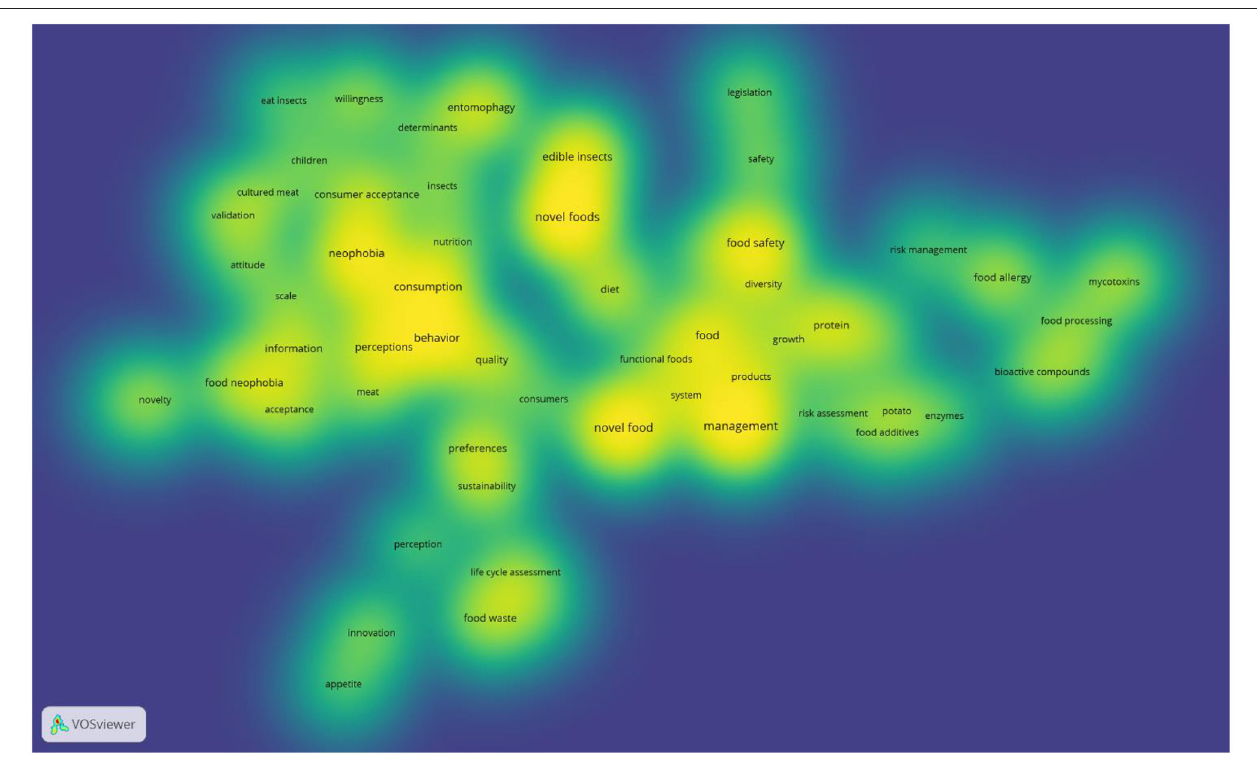
FIGURE 9 | Density map (Source: our elaboration).